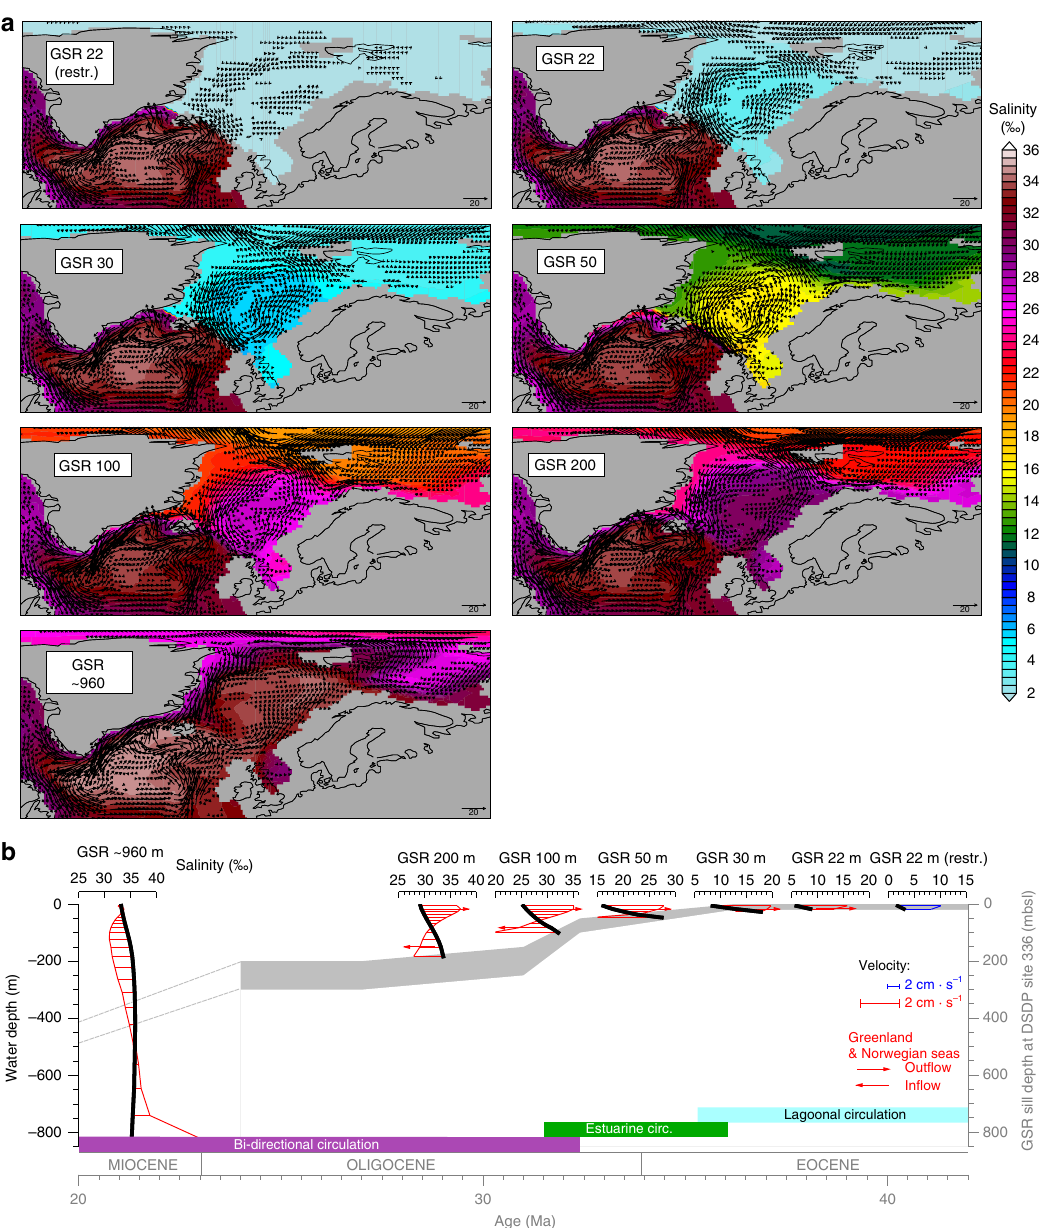
Figure 3 | Seaway opening evolution for the last 42Ma in context of the Greenland–Scotland Ridge subsidence history. ( a ) Salinity ( % ) and ocean velocity (cms (cid:2) 1 ; velocities o 0.5cms (cid:2) 1 are not shown) maps at water depths of 50m for the model scenarios (EO) at different sill depths of the Greenland–Scotland Ridge (GSR). ( b ) Modelled salinity and velocity profiles across the GSR section (Fig. 1) for the preindustrial (PI) and Miocene GSR sill depths are displayed in context of the subsidence evolution as derived from DSDP site 336 (refs